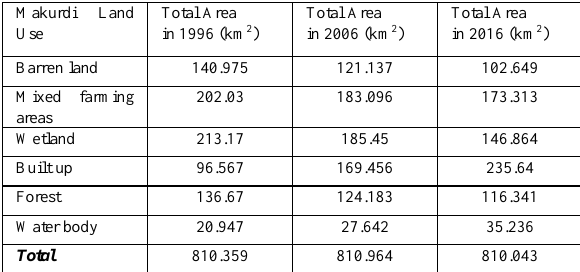
Table 5. Landuse composition of study area (Km 2 ) in 1996, 2006 & 2016.